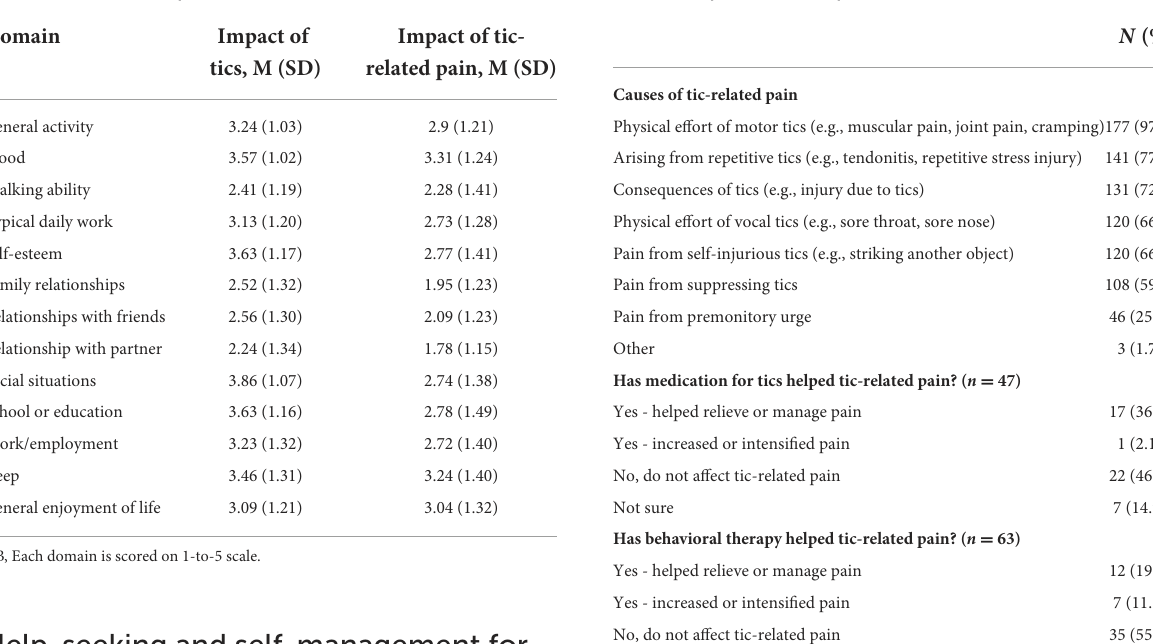
TABLE 4 Self-reported causes of tic-related pain and impact of treatment upon tic-related pain.